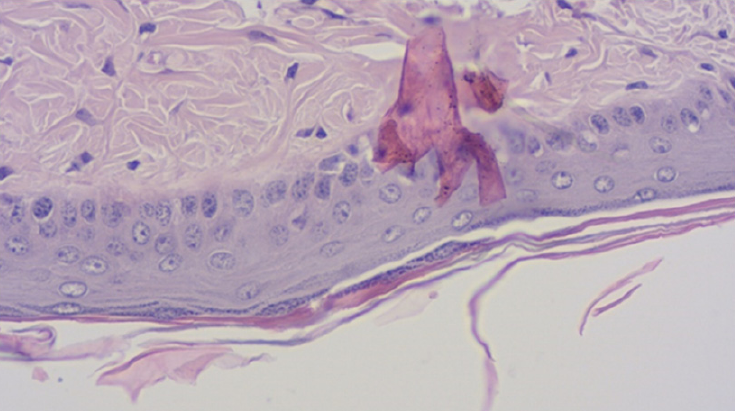
Figure 2. Section with granular layer, hematoxylin–eosin staining, 40× objective.